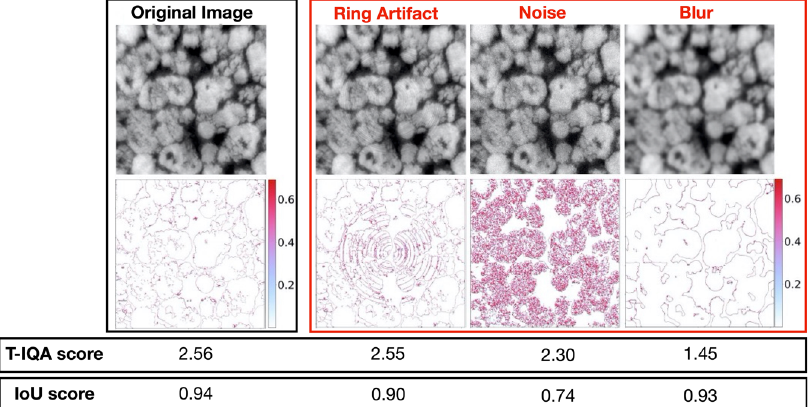
Fig. 6 Results of differently distorted images evaluated by TIQA and segmentation. For the F1 score, it is in the range of 0 (the worst) and 1 (the best).